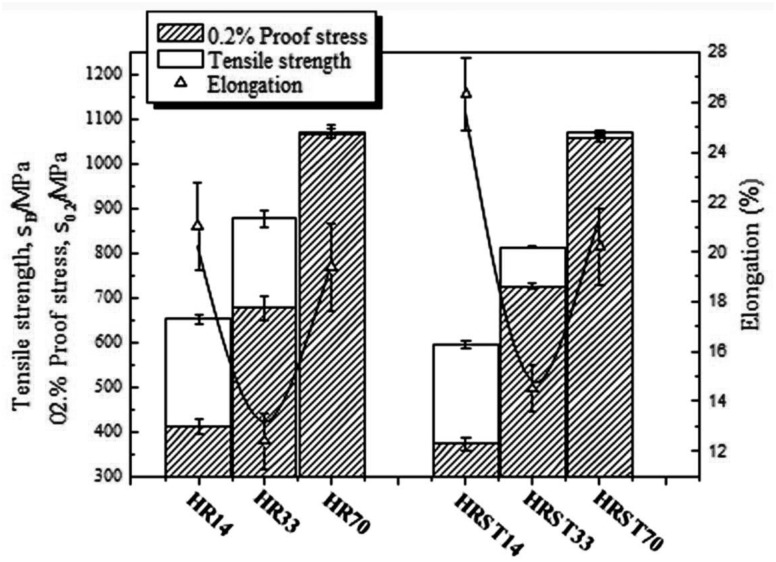
Tensile properties: tensile strength, 0.2% proof stress and elongation of TNTZ-0.14O, TNTZ-0.33O and TNTZ-0.70O subjected to hot rolling (HR14, HR33 and HR70), and solution treatment at 1003, 1083 and 1243 K for 3.6 ks after hot rolling (HRST14, HRST33 and HRST70).